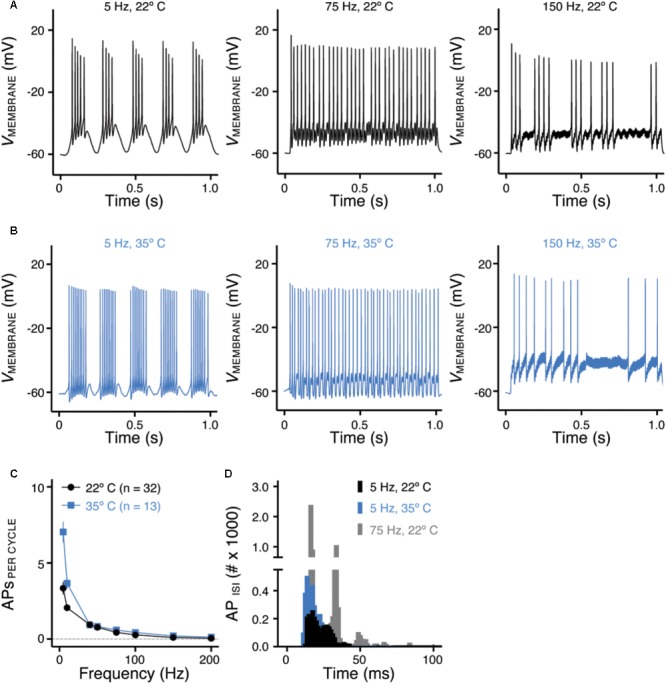
Frequency-firing pattern of NMc neurons to sinusoidal current injections. (A,B) Representative voltage traces recorded from NMc neurons in response to 5, 75, and 150 Hz sinusoidal current injections at 22°C (A) or 35°C (B) recording temperature. The strength of sinusoidal current injections is 200 or 300 pA. (C) Population data showing the evoked APs per sinusoidal cycle plotted as a function of stimulus frequency for NMc neurons. (D) Histogram of the inter-spike intervals (ISIs) calculated from APs in response to 5 and 75 Hz sinusoidal current injections. Error bar = standard error.